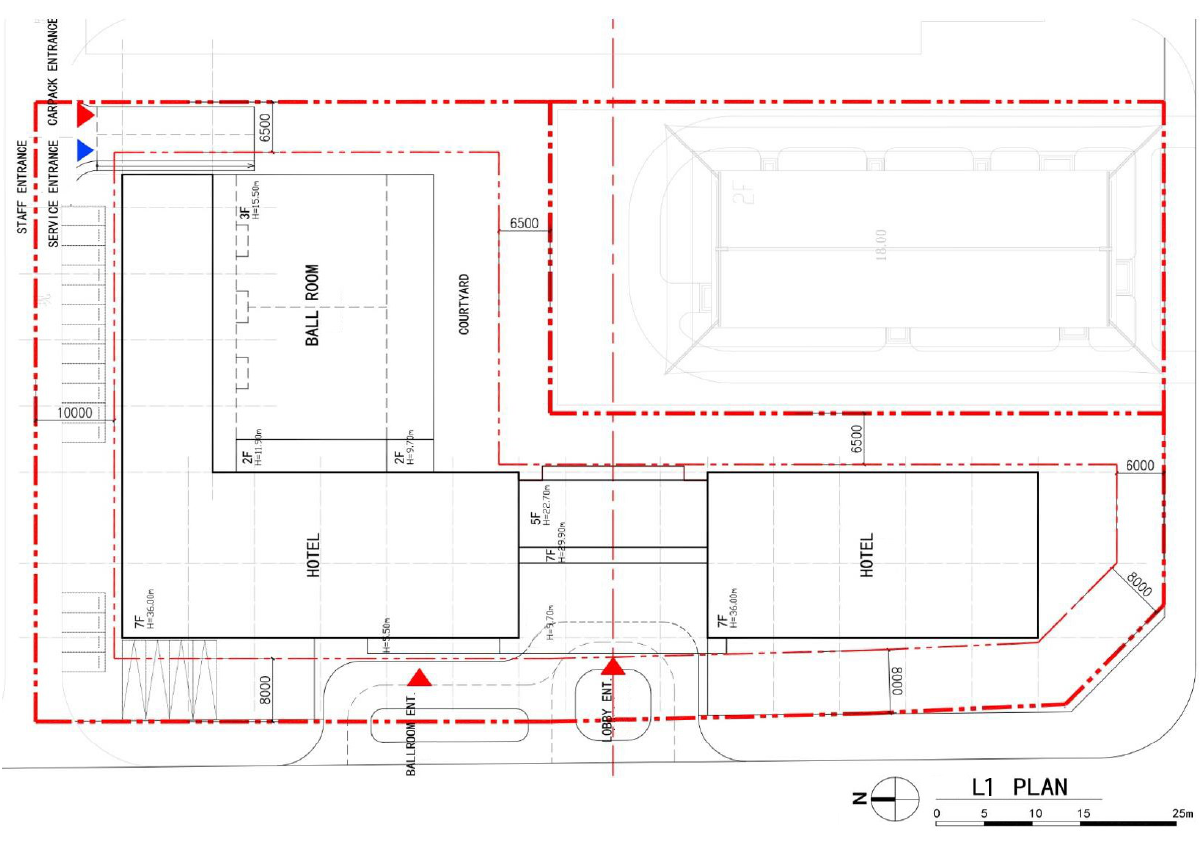
Figure 3. Location map of the object.